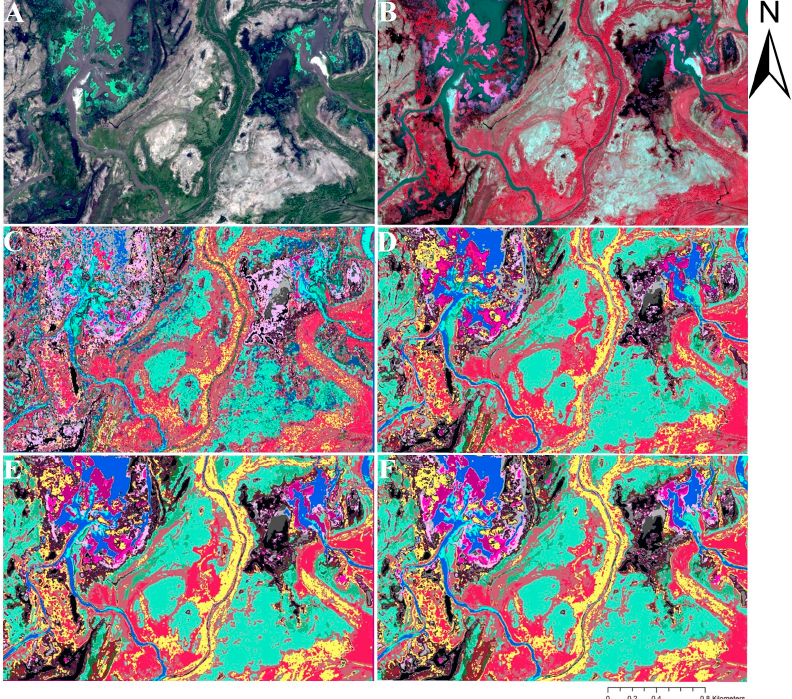
Figure 5. Wetland classification thematic maps of a select study area generated using the smallest ROI-size training data (ROI-ID D12; see Figure 2): ( A ) true-color WV2 bands 532, and ( B ) false-color WV2 bands 753 composite, ( C ) MLM, ( D ) GLM, ( E ) SVM, and ( F ) RF models. Colors depicted follow the wetland classes given in Table 1.